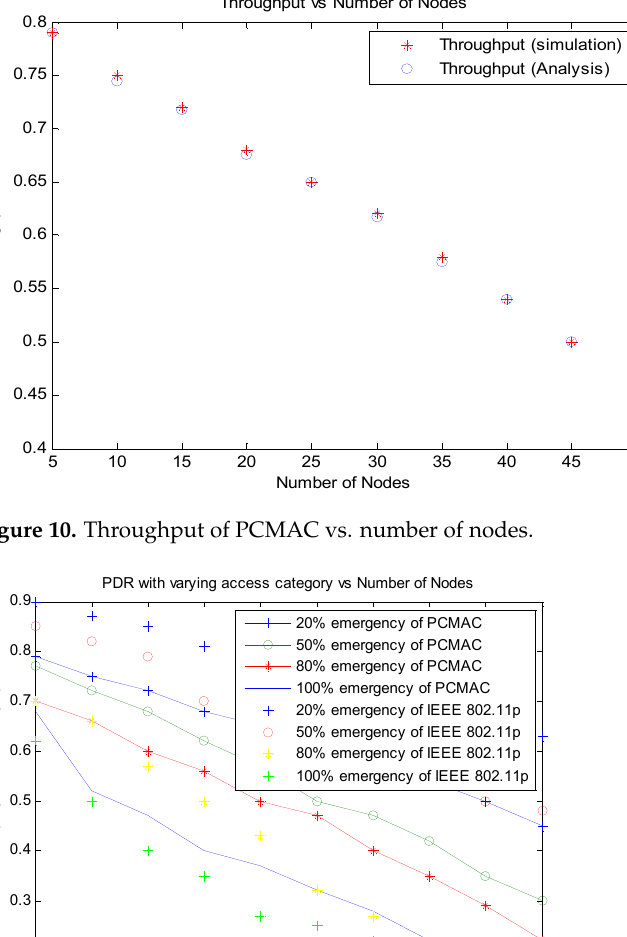
Figure 10. Throughput of PCMAC vs. number of nodes.